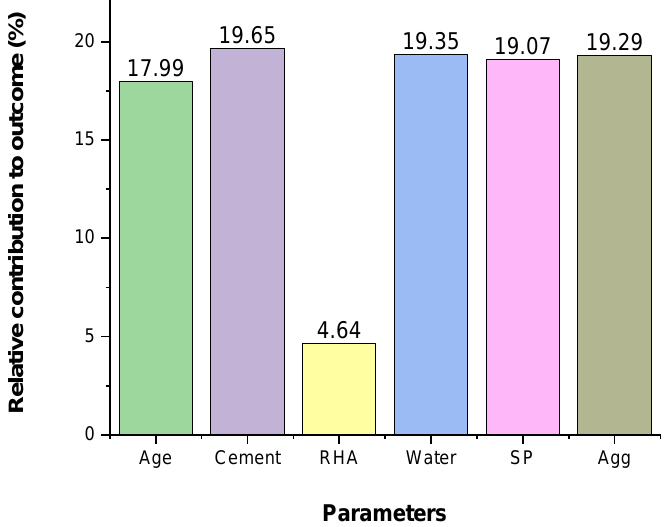
Figure 10. Contribution of inputs to the output.